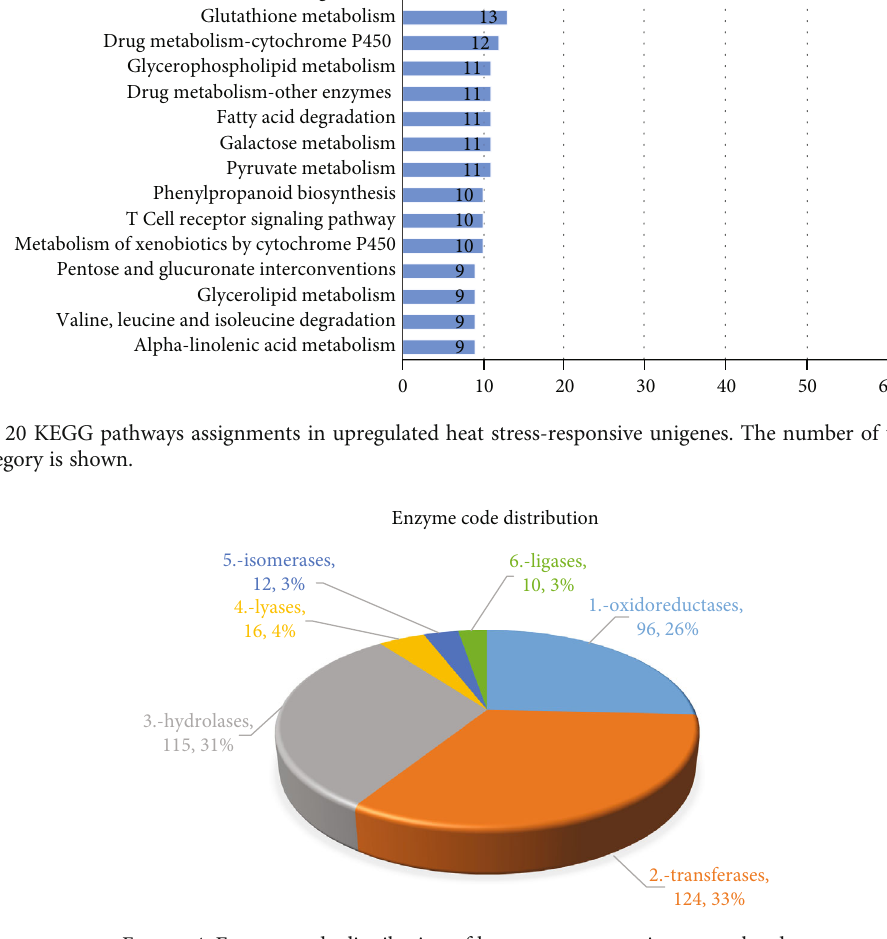
Figure 4: Enzyme code distribution of heat stress-responsive upregulated.